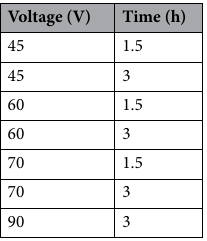
Table 1. Time and voltage used in anodizing process.